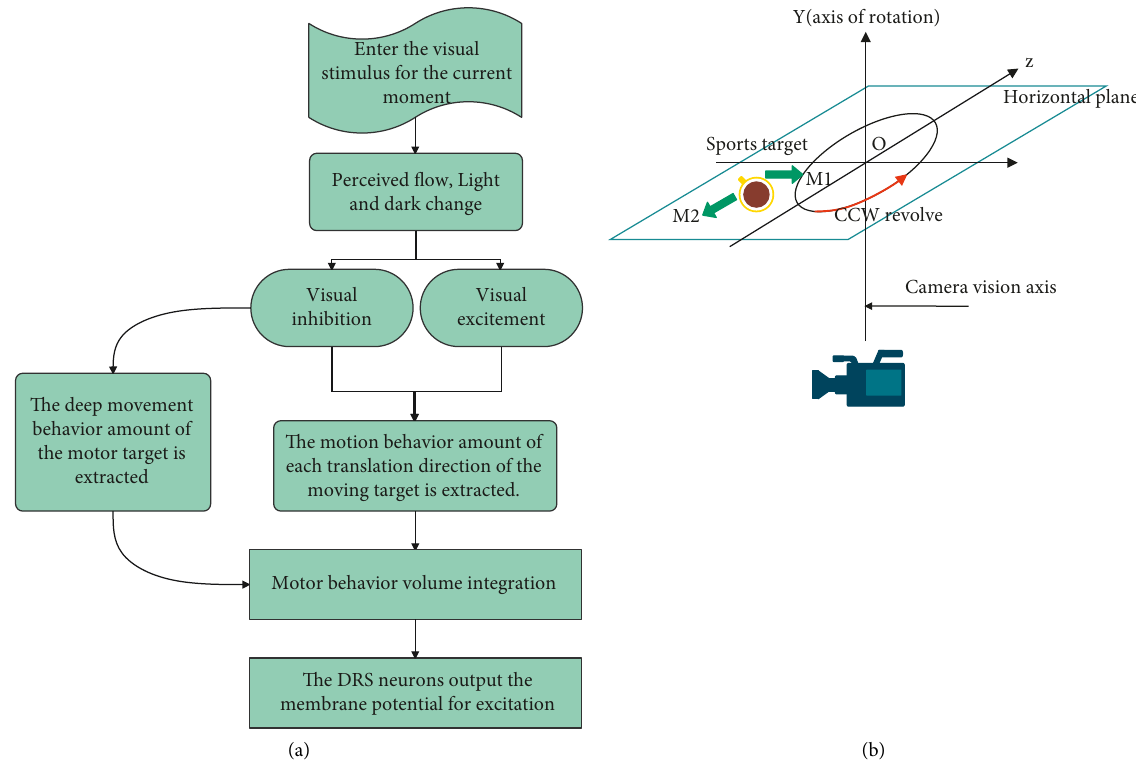
Figure 7: (a) Schematic diagram of the basic visual mechanism of deep rotational motion perception by DRS neurons. (b) Schematic diagram of the hidden visual motion behavior of a moving target that performs counterclockwise depth rotation motion on the horizontal plane. M 1 in the figure represents the translation direction, and M 2 represents the depth motion